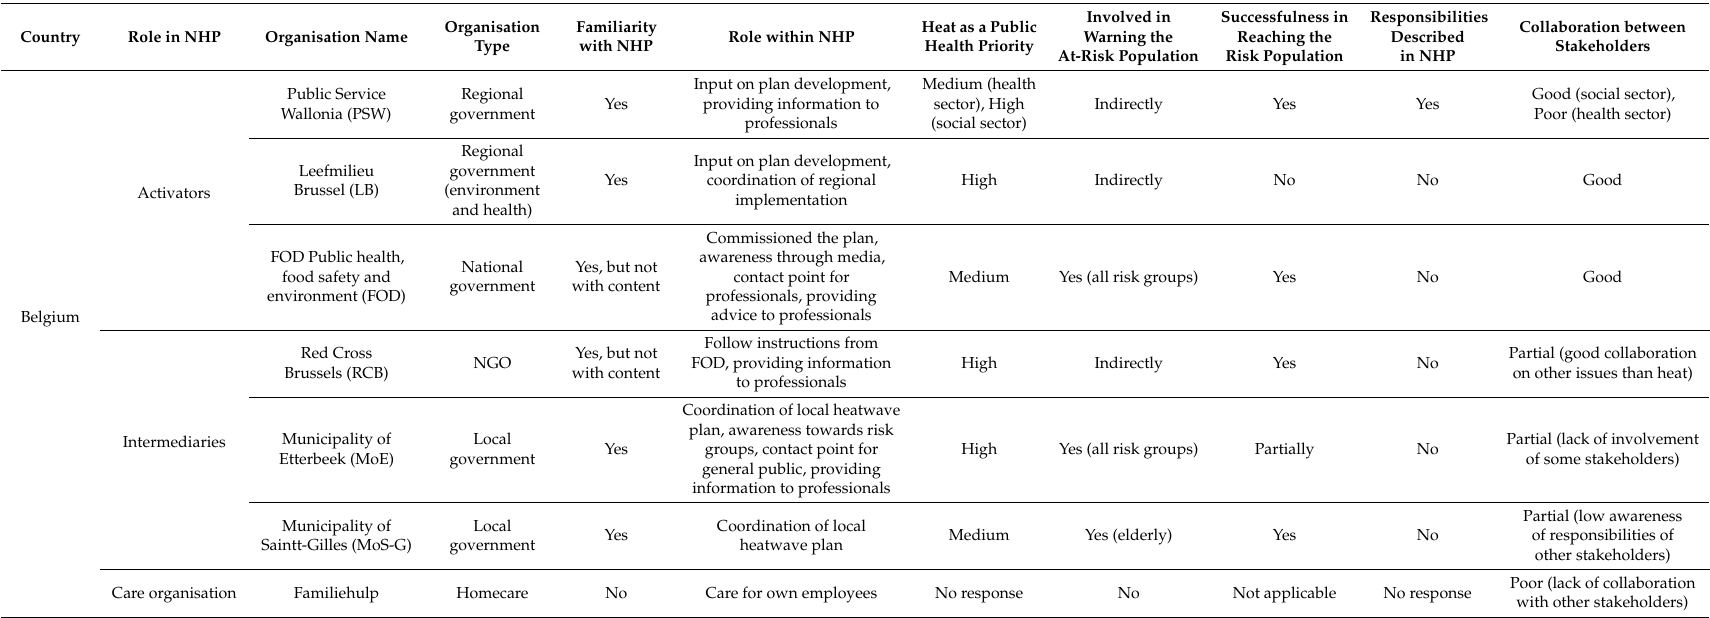
Table 4. Overview of interviews with selected key informants in